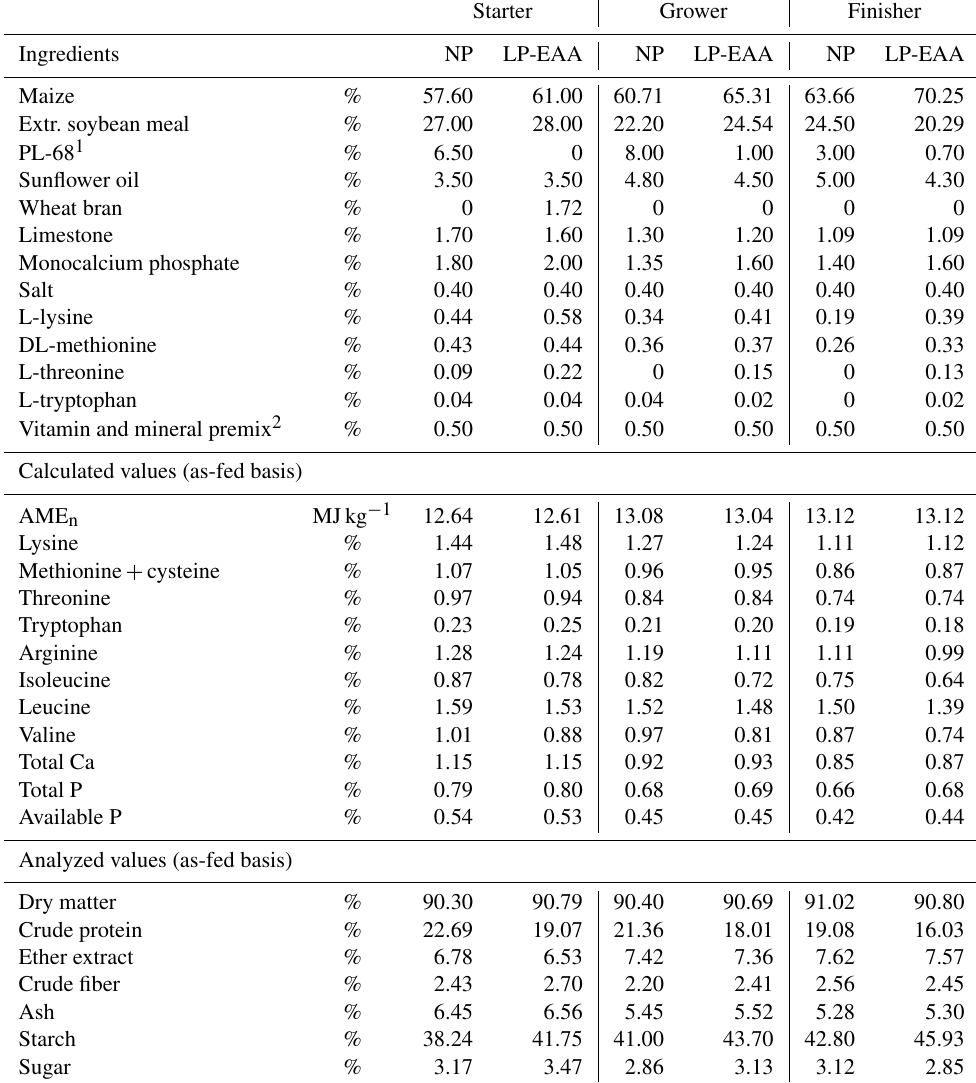
Abbreviations used: NP – normal protein diet with normal dietary crude protein levels; LP-EAA – low-protein diet supplemented with essential amino acid (L-lysine, DL-methionine, L-threonine and L-tryptophan); AME n – nitrogen-corrected apparent metabolizable energy; AME n (per kg) = 0 . 155 × % crude protein + 0 . 343 × % ether extract + 0 . 1669 × % starch + 0 . 130 × % sugar (Commission Regulation (EC) no. 152/2009). 1 Protein concentrate, by-product of glutamic acid production from bacterial biomass (KJK-Agroteam Ltd., Hungary). Amino acid contents: L-lysine 2.4%, DL-methionine 0.9%, L-cysteine 0.2%, L-threonine 3.0%, L-proline: 1.6%, L-arginine 3.1%, L-serine 2.4%, L-glutamine 12.3%, L-tryptophan 0.69%, glycine 2.4%, L-alanine 6.0%, L-valine 3.2%, L-isoleucine 2.4%,